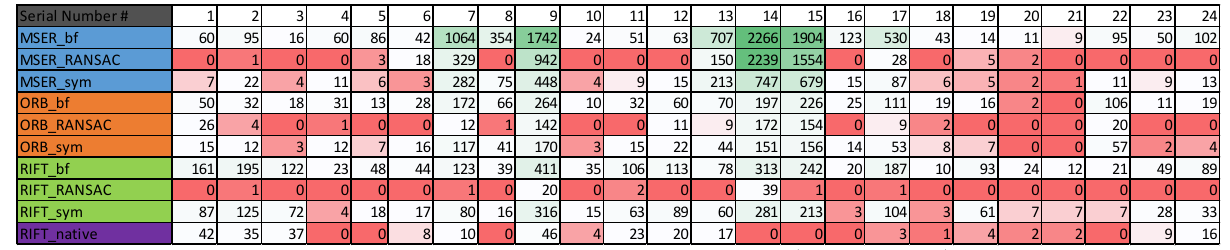
Table 2. Results for different feature matching methods for 8 different image triples (=24 image pairs). The total number of correct matches is shown respectively for every dataset for the image pairs 1_2, 1_3 and 2_3. Good results are highlighted in green whereas bad results are shown in